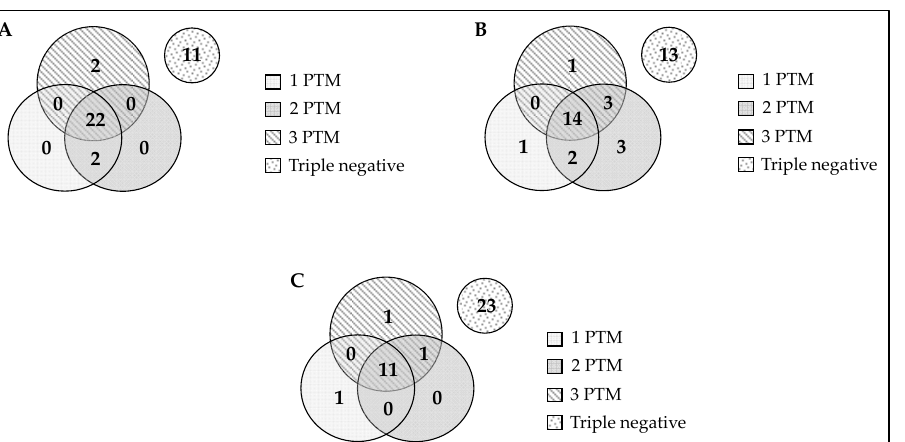
Figure 4. Isotype antibodies overlap in ILD patients ( A ) IgG, ( B ) IgA and ( C ) IgM. Overlap between anti-CFFCP1 (chimeric cyclic peptide bearing one PTM: citrulline), anti-CFFCHP1 (chimeric cyclic peptide bearing two PTMs: citrulline and homocitrulline) and anti-CFFCHAP (chimeric cyclic peptide bearing three PTMs: citrulline, homocitrulline and acetyl-lysine) antibodies.